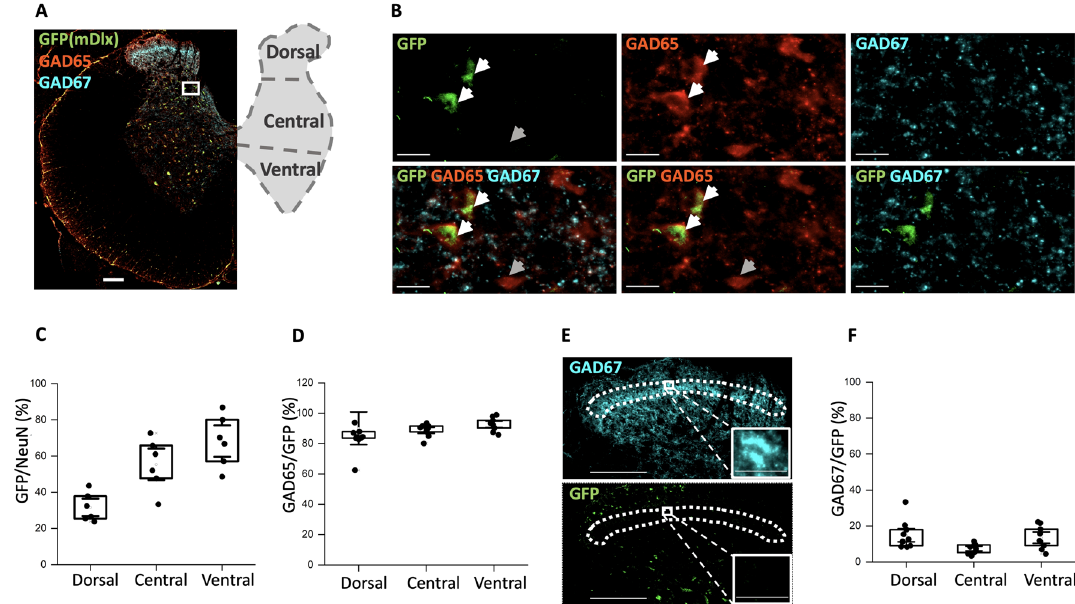
Figure 2. The AAV2-mDlx enhancer primarily expressed in GAD65-containing neurons in the lumbar spinal cord. ( A ) Sample tissue section and illustration of the spinal cord showing a distinct layer of GAD67-containing synaptic terminals and neurons (cyan) whereas GAD65-containing neurons are more dispersed (red). The AAV2-mDlx-driven viral expression is shown in green (GFP). ( B ) A highlighted section (panel A ) indicates co-localization of GFP and GAD65, but not GAD67. There are also instances of GAD65+ cells where GFP was not expressed (dim arrow). ( C , D ) Fraction of co-localization of GFP+ cells and cells containing NeuN ( C , N = 2 rats, n = 3 sections/rat) and GAD65 ( D , N = 3 animals, n = 3 sections) in the three dorso-ventral regions. ( E ) The dense layer of GAD67-containing neurons in the dorsal horn (substantia gelatinosa) has little or no overlap with GFP. (F) Cell count (shown as %) of the co-expression in the three regions between GAD67 and GFP positive cells (N = 3 animals, n = 3